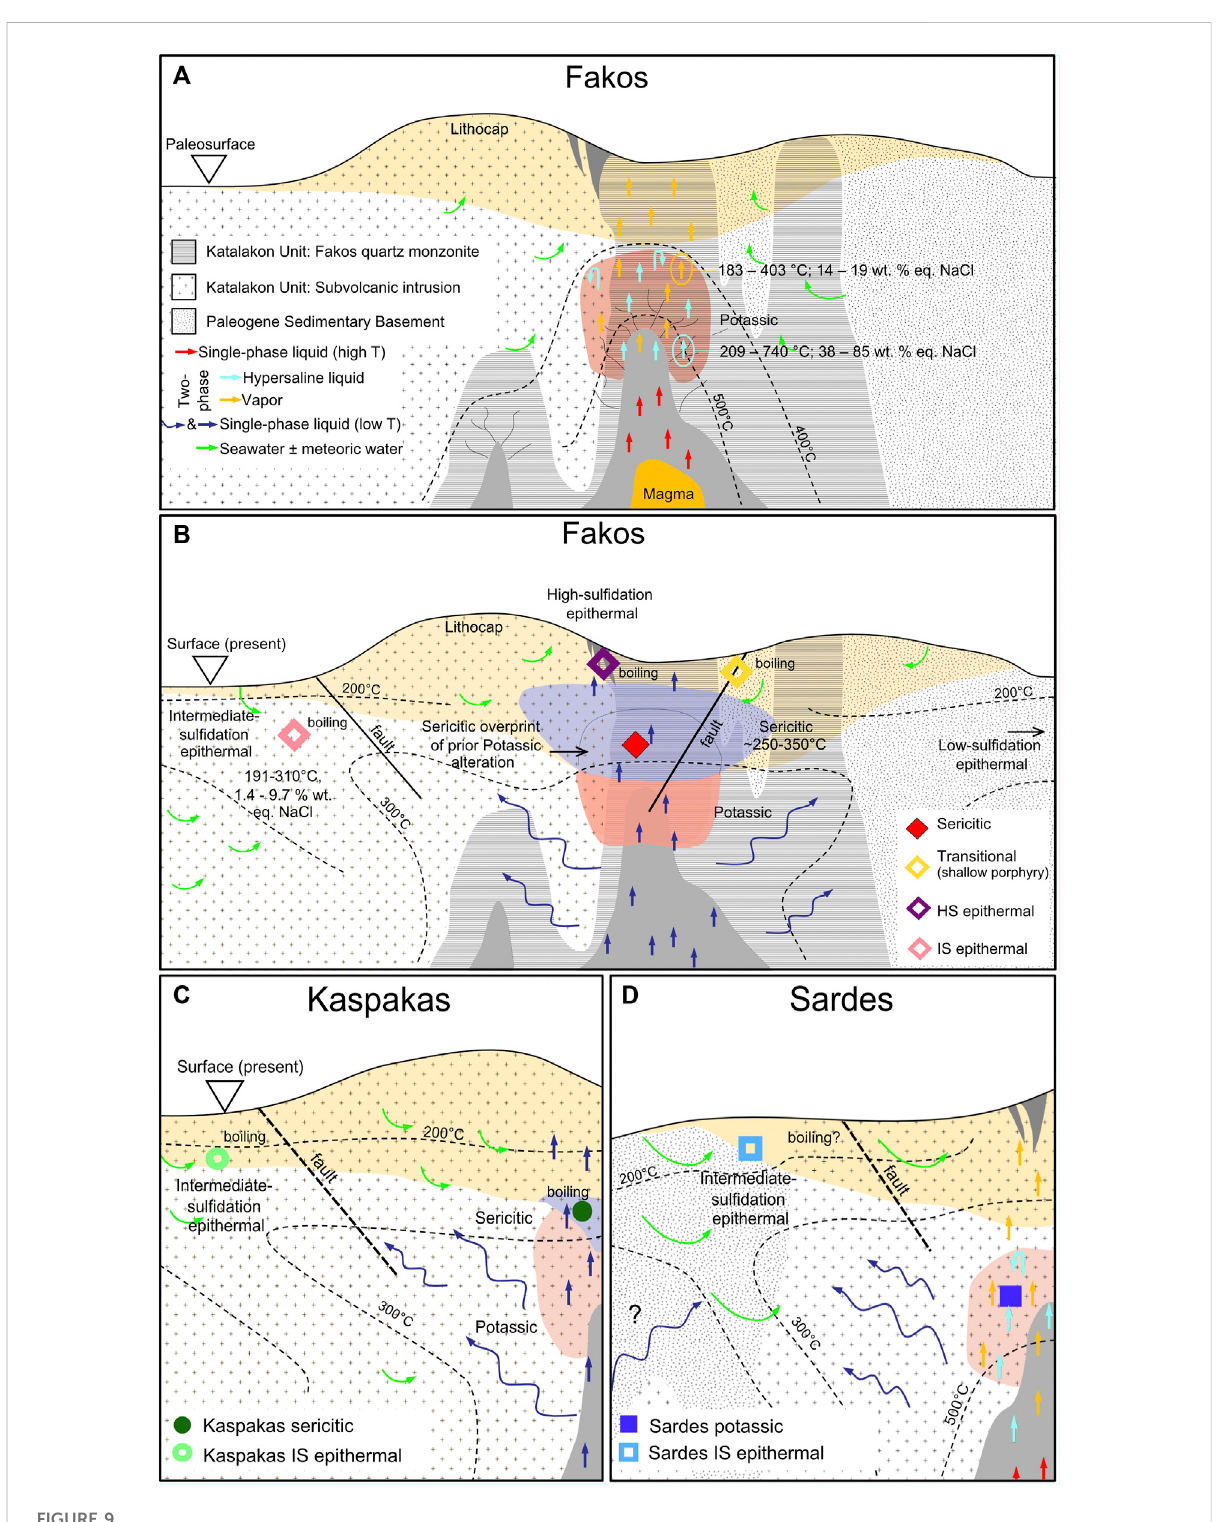
FIGURE 9 Schematic model for the porphyry-epithermal evolution of the three distinct hydrothermal systems: Fakos (A,B) , Kaspakas (C) and Sardes (D) . Modi fi ed after Sillitoe (2010). Details about the different processes as presented in the text (cf. Sections 5.2, 5.3).